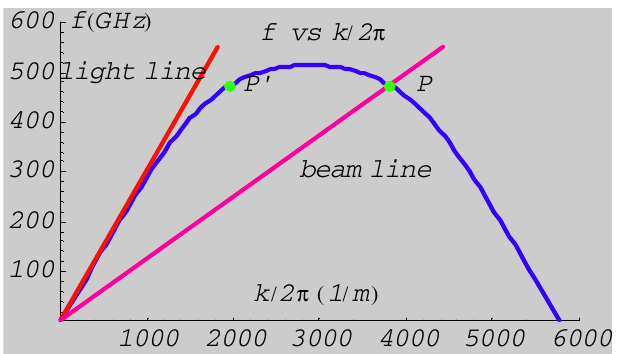
FIG. 2. (Color) Dispersion relation for the Dartmouth grating according to Andrews and Brau. The operating point P is shown, as well as a second point P 0 which has the same frequency but wave number k 0 (cid:1) K (cid:3) k . The solutions P and P 0 go into each other upon